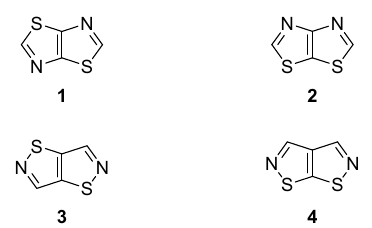
Figure 1. Known [1,2] and [1,3] thiazolothiazole ring systems 1 – 4 .